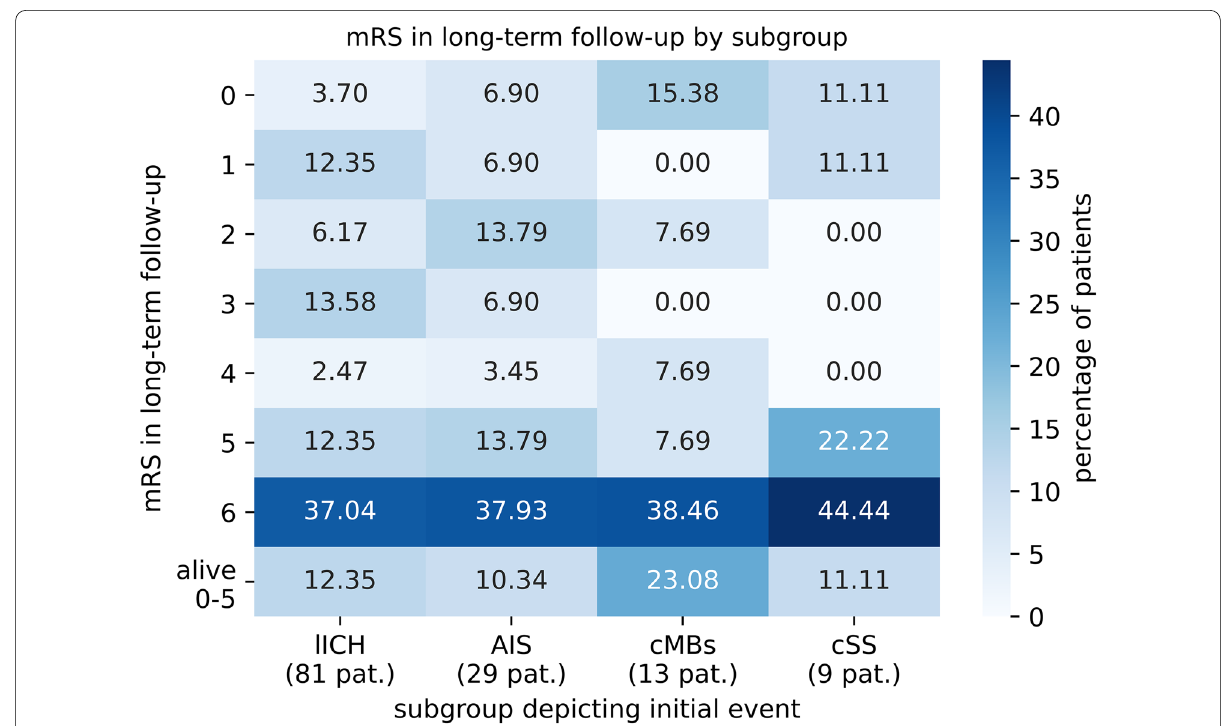
Fig. 3 Heatmap of the different mRS scores upon long term follow up, split by subgroups (numbers given within the map: percentages; total number in the long‑term follow‑up: below the group classifications)